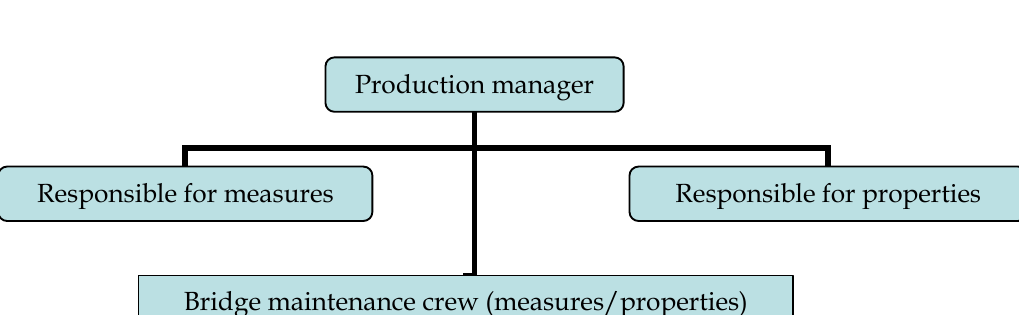
Figure 2. The selected contractor’s project